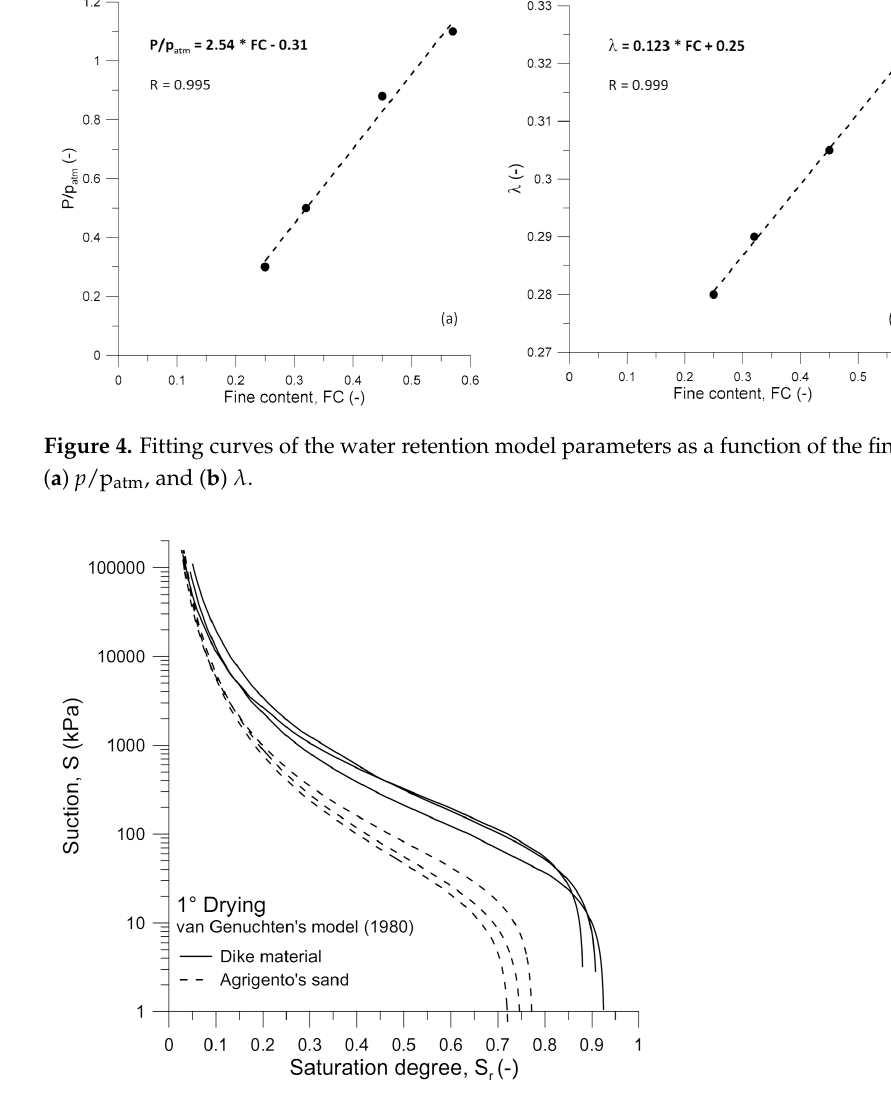
Figure 5. Fitting curves of the samples